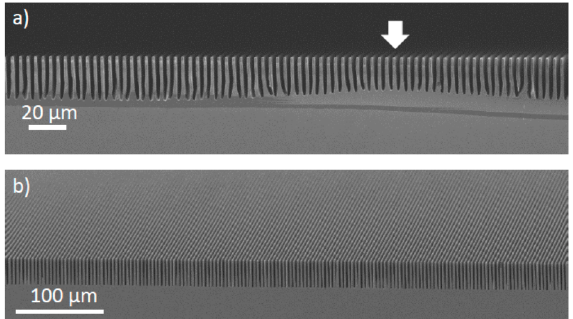
Figure 5. SEM in cross-section of 4.8 µm pitch grating etched with regular MacEtch ( a ) and MacEtch solution with the addition of isopropanol alcohol ( b ). The arrows indicate the presence of a gas bubble preventing the uniform etching of the grating. The figure was adapted with permission from L. Romano et al., 2017. [40].